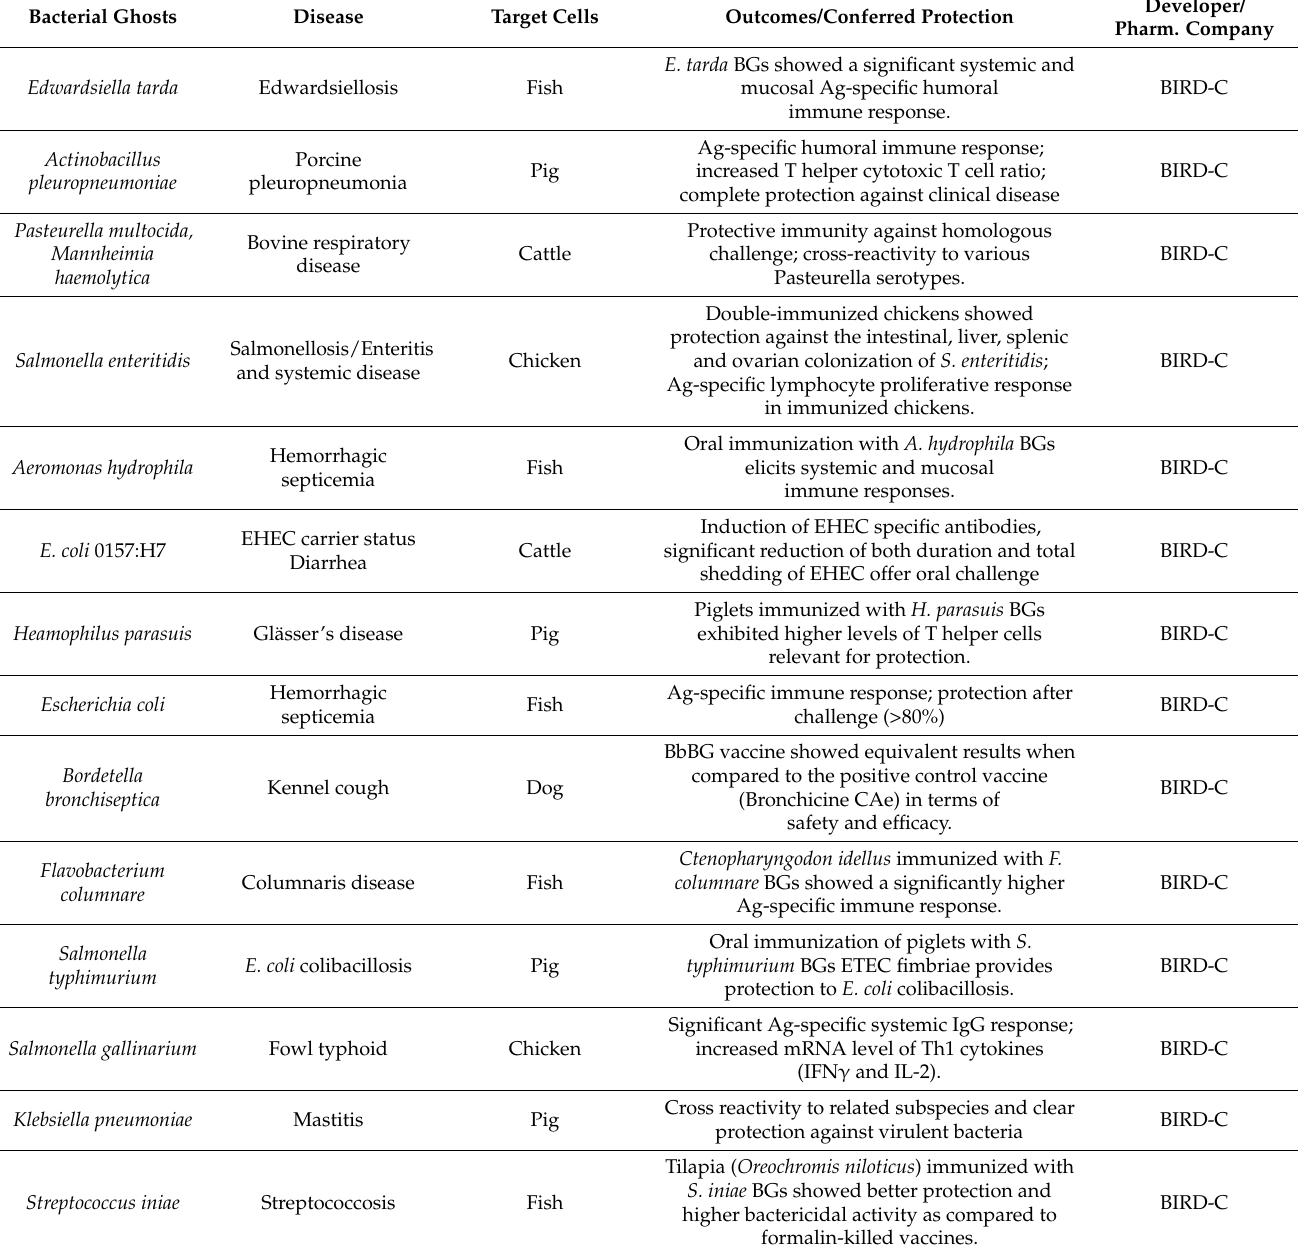
Table 4. Clinical significance/Outcomes of